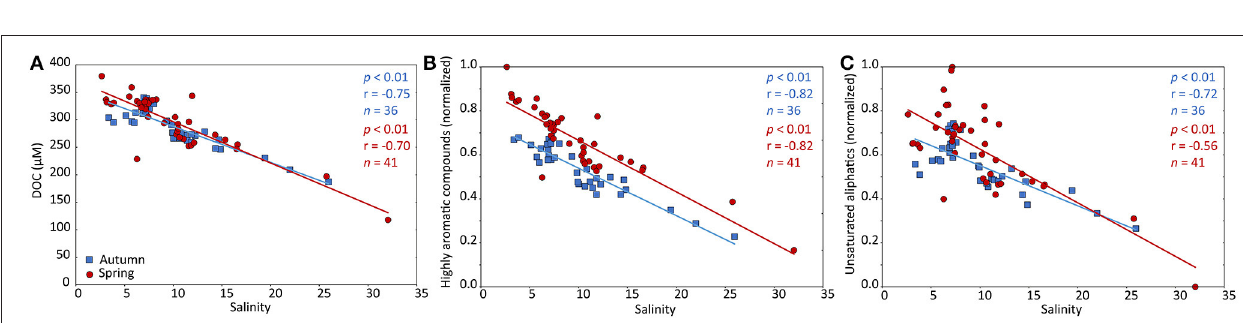
Frontiers in Earth Science | www.frontiersin.org